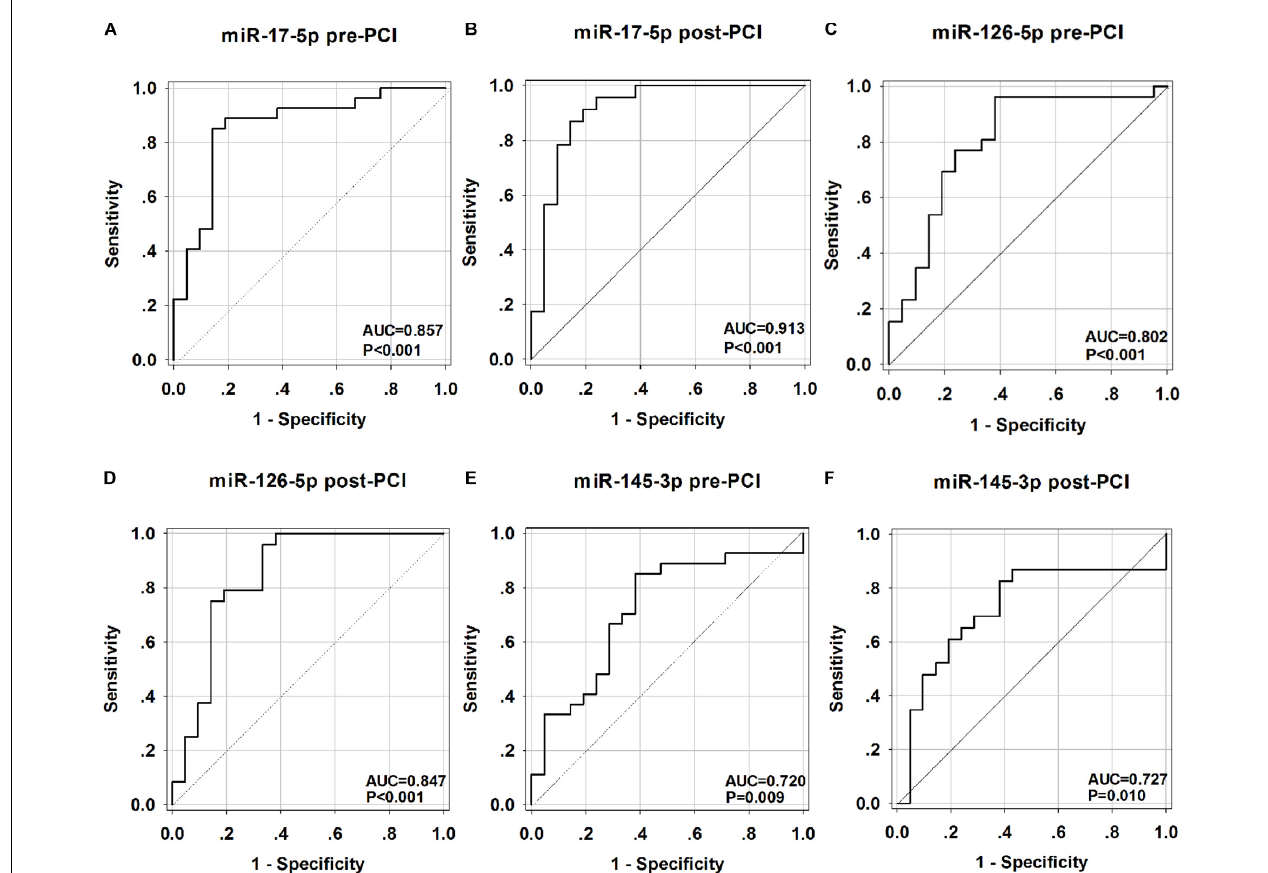
FIGURE 5 | Receiver operating characteristic (ROC) curves analysis of miR-17-5p, miR-126-5p, miR-145-3p for predicting AMI. The areas under the curves (AUC) are 0.857 (95% CI: 0.744–0.965, p < 0.001) for miR-17-5p-before PCI (A) , 0.913 (95% CI: 0.821–1.005, p < 0.001) for miR-17-5p-after PCI (B) , 0.802 (95% CI: